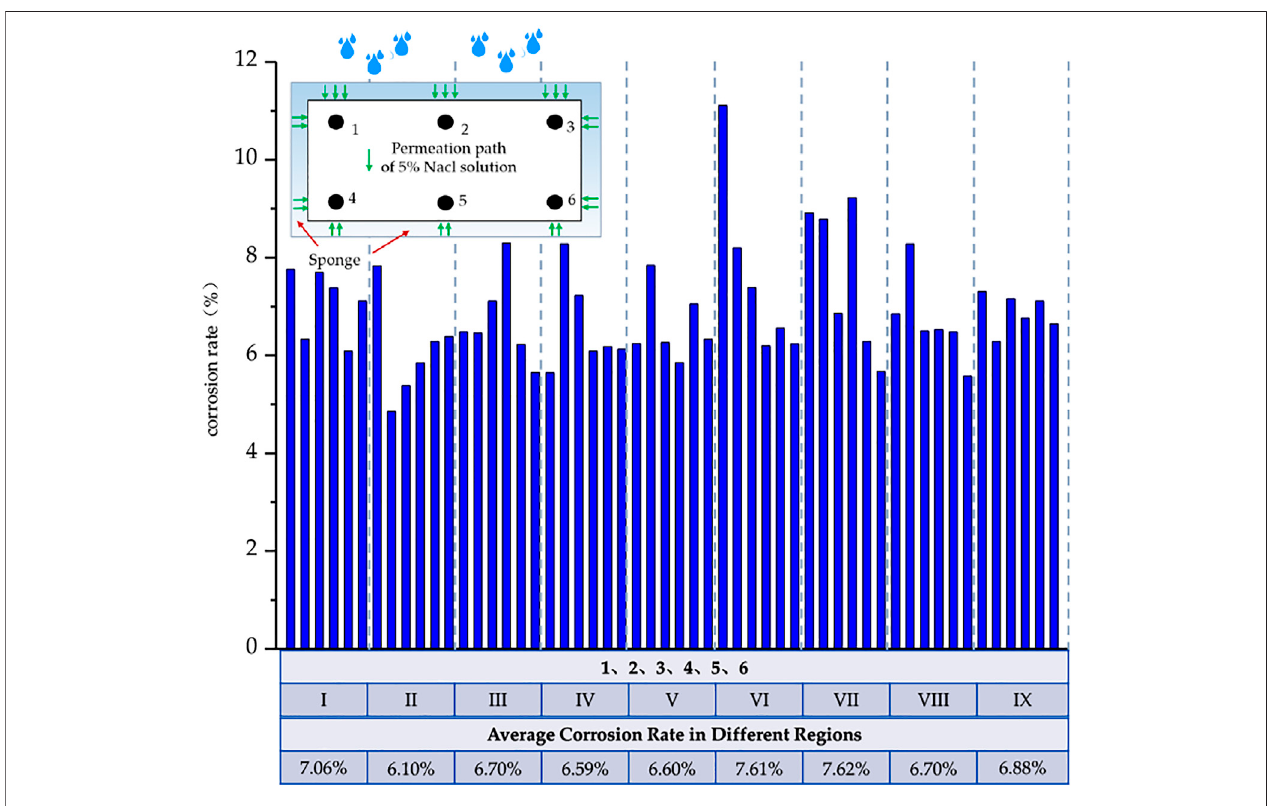
FIGURE 7 | Corrosion rate of reinforcement in each corrosion section.